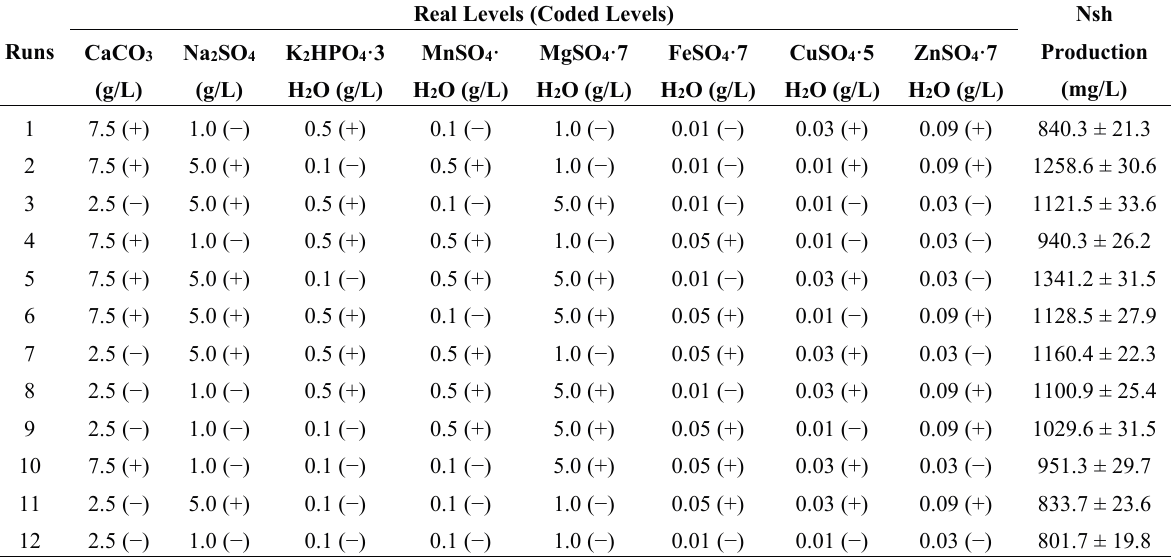
Table 1. Plackett-Burman experimental design and Nsh